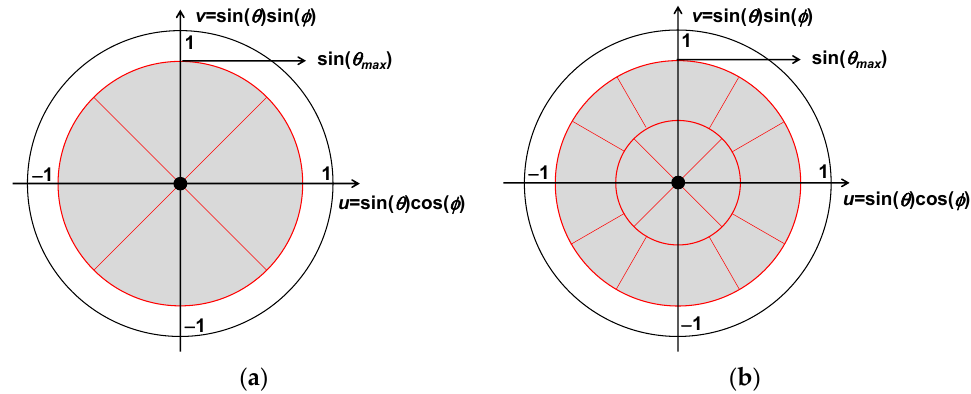
Figure 7. Example of cells configuration in the uv plane: ( a ) single layer with n = 8 cells and ( b ) two layers with n = 20 cells.